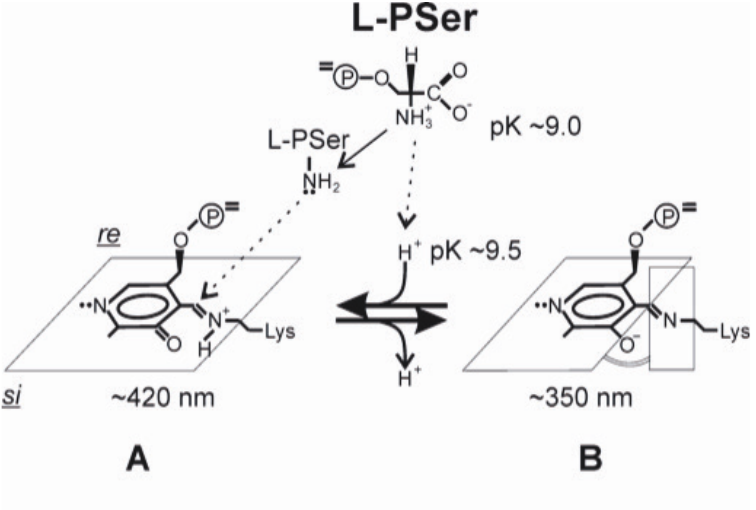
Figure 7: A schematic presentation of the initial step of the reaction of L-PSer with PSAT active site. The structures of PLP ketoenamine (A) and enolimine (B) are drawn schematically not considering possible mesomeric structures or connections to apoenzyme. In (A) the planar structure includes the azomethine nitrogen with Lysine residue. When the azomethine nitrogen loses proton (pK (B) and the azomethine bond makes another plane with an angle to plane (A). During the reaction, the amino group of the substrate (PSer or Glu) should attach to carbon C4´ shown by arrow in (A) since that carbon is distinctly more electropositive than the same carbon in